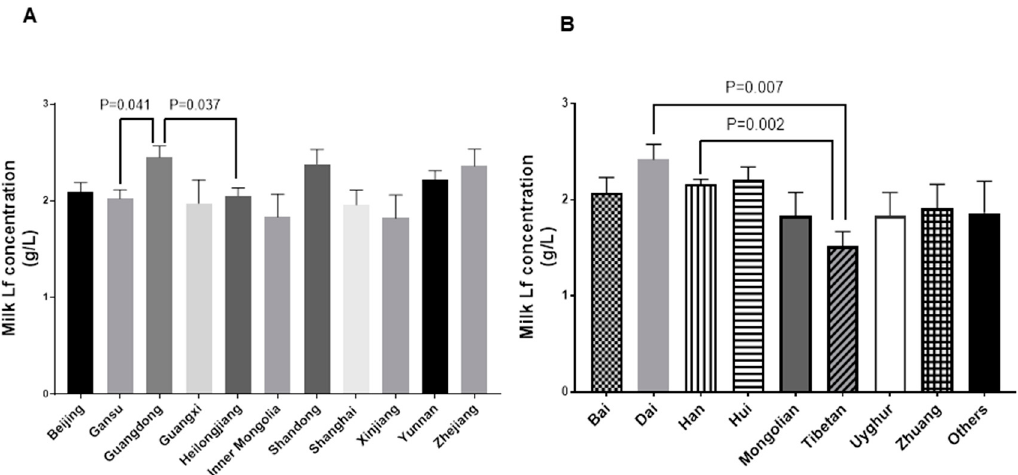
Figure 3. Milk Lf concentrations among various geographical regions and ethnicities in China ( A ) Average milk Lf concentrations from three lactation stages in 11 regions, overall p = 0.02, Guangdong vs. Heilongjiang, p = 0.037; Guangdong vs. Gansu p = 0.041. ( B ) Average milk Lf concentrations in different Chinese populations, overall p = 0.01, Dai vs. Tibetan, p = 0.007; Han vs. Tibetan, p = 0.002. General linear model with Tukey adjusted method was used. Data are shown as means ± SD.